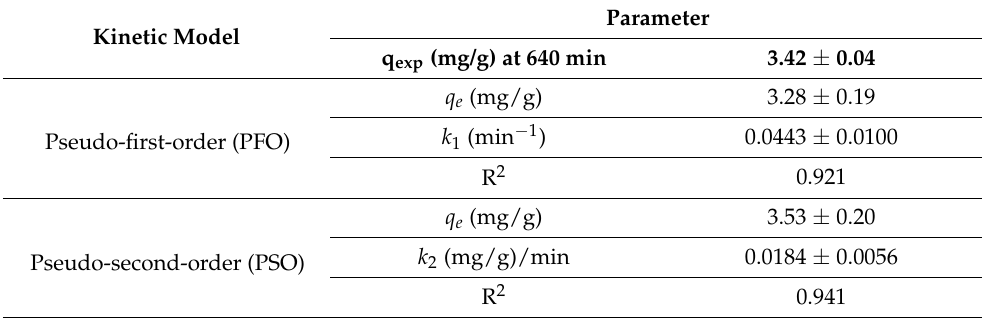
Table 4. Parameters of the pseudo-first-order and pseudo-second-order kinetic models fitted by the MO adsorption data of P-MMt-C400.